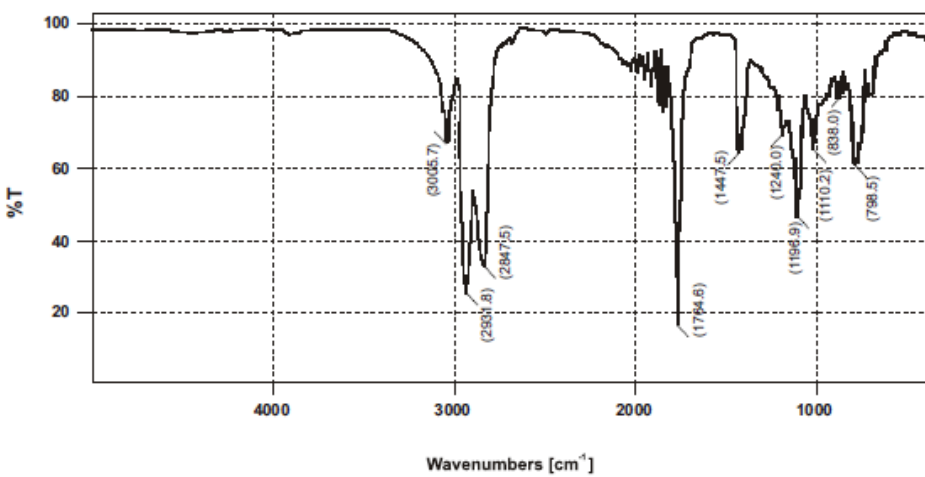
Figure 3. A typical FTIR Spectrum of